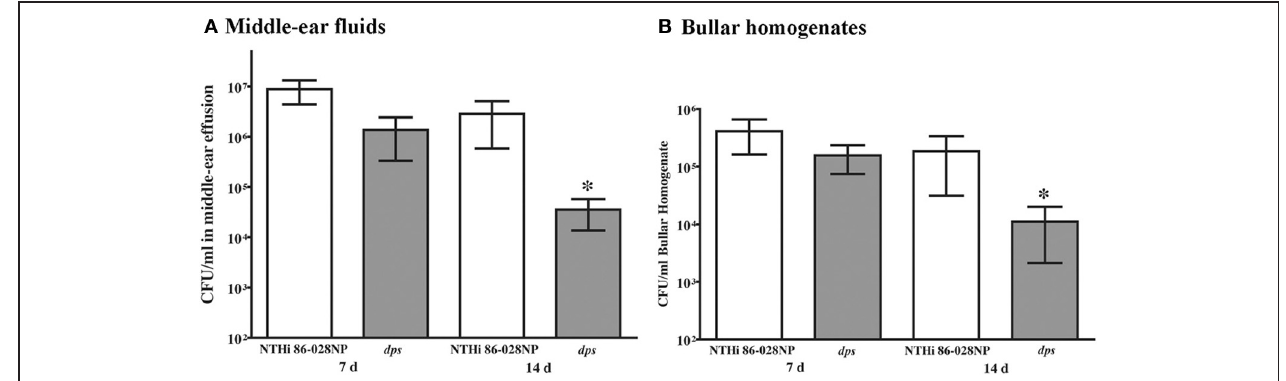
FIGURE 6 | Effectof dps onNTHipersistenceinthechinchillamodelfor otitismedia. Animalswere anesthetized and infected with ∼ 1000CFU as indicated via transbullar injection, and groups (3/group) were euthanized